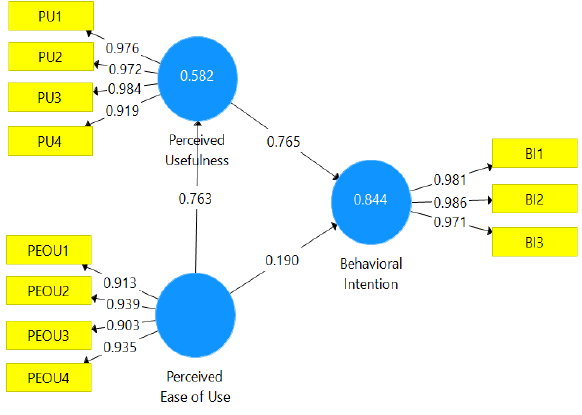
Figure 3. Results from PLS algorithm – Time